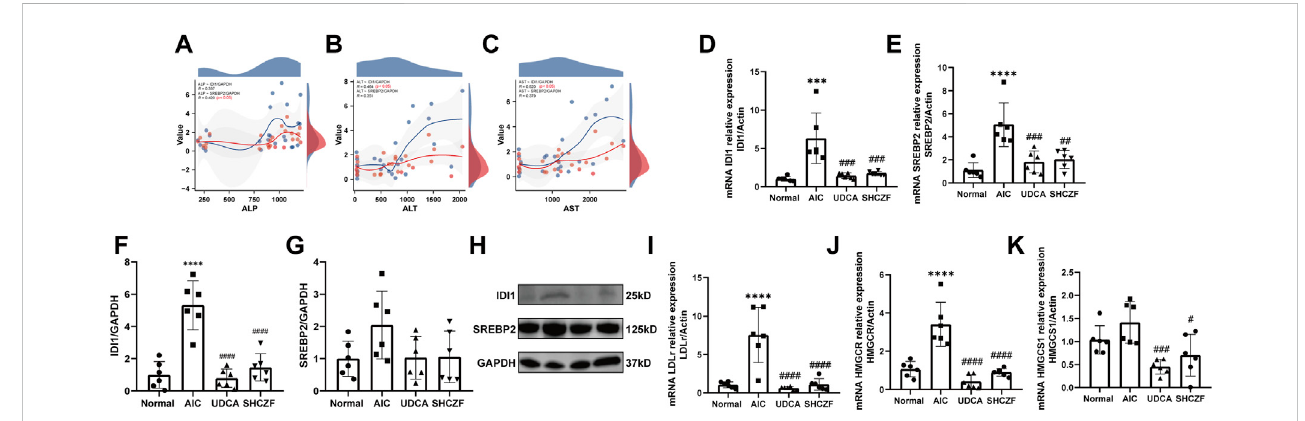
FIGURE 8 Expression of SHCZF target genes and cholesterol metabolism-related genes. (A) Correlation between IDI1, SREBP2, and ALP, (B) Correlation between IDI1,SREBP2,andALT, (C) Correlation betweenIDI1,SREBP2,andAST, (D) mRNAexpressionofIDI1, (E) mRNAexpressionofSREBP2, (F) proteinexpressionof IDI1, (G) protein expression of SREBP2, (H) WB bands of IDI1, SREBP2, and GAPDH, (I) mRNA expression of LDLr, (J) mRNA expression of HMGCR, (K) mRNA expression of HMGCS1.